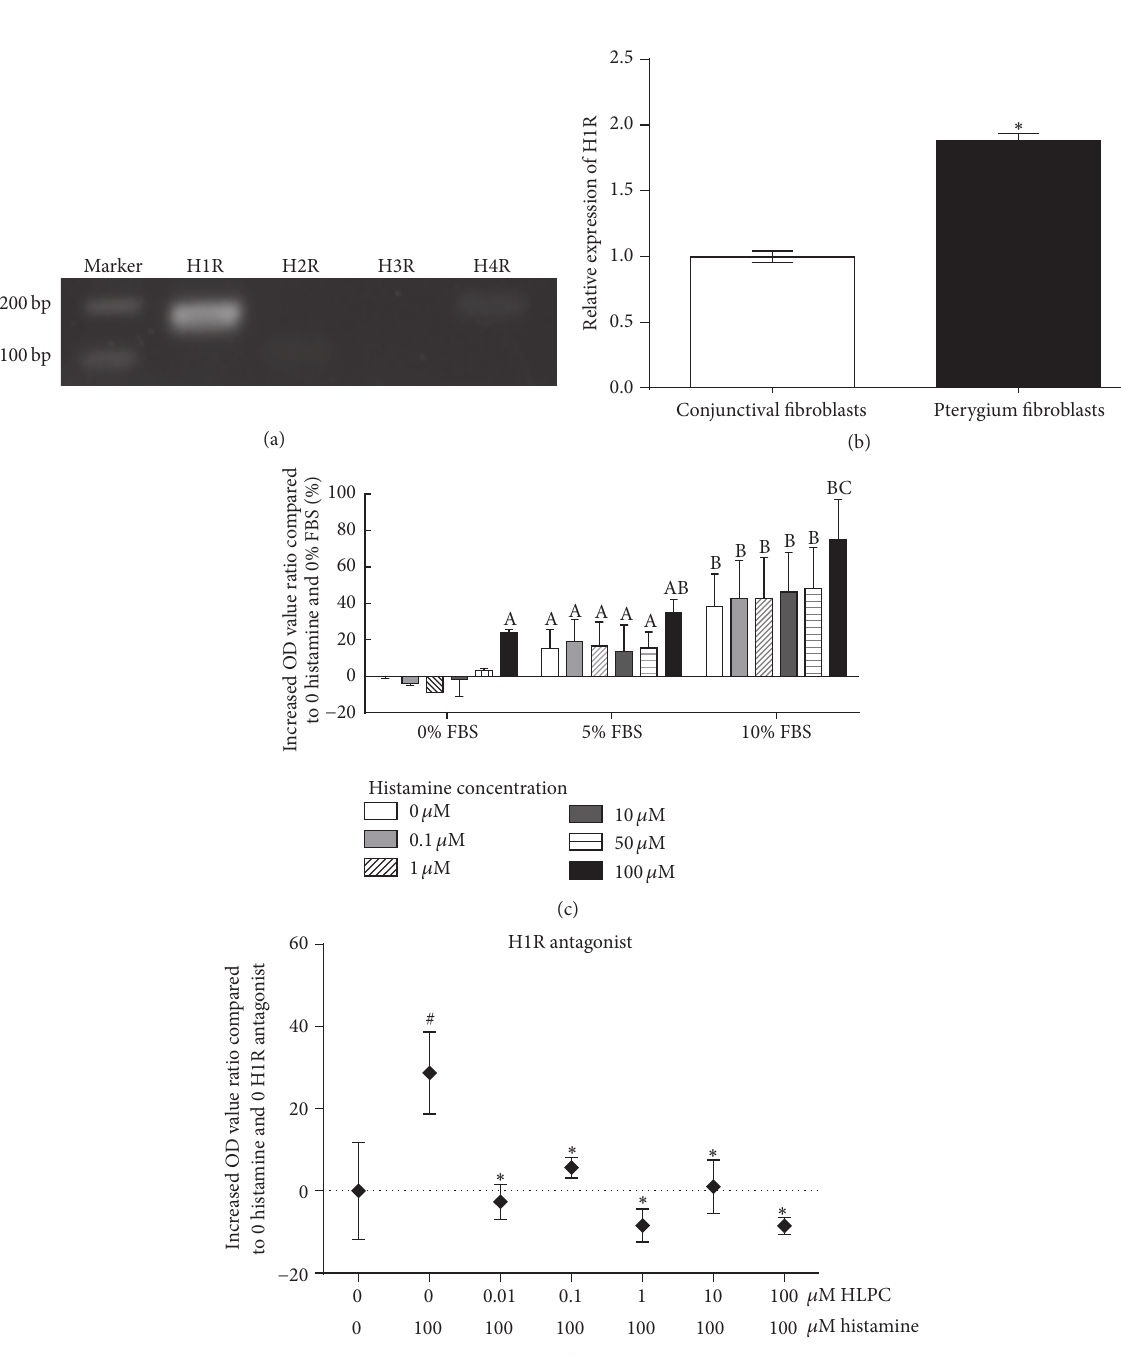
Figure 5: Histamine also showed proliferative effect on HCFs but at a higher effective concentration than on HPFs. (a) DNA agarose gel electrophoresis showed the expression of H1R, H2R, and H4R on HCFs, and the expression of H2R and H4R was quite few. (b) RT-qPCR showed that the expression of H1R in HCFs was only half of those in HPFs. (c) MTT assay showed that histamine had proliferative effect on HCFs in 0%, 5%, and 10% FBS situation at concentration of 100 𝜇 mol/L. A 𝑃 < 0.05 compared to 0 histamine and 0% FBS, B 𝑃 < 0.05 compared to 0 histamine and 5% FBS, C 𝑃 < 0.05 compared to 0 histamine and 10% FBS. (d) MTT assay showed that H1R antagonist could efficiently inhibit the proliferative effect of histamine. ∗ 𝑃 < 0.05 compared to incubation with 100 𝜇 mol/L of histamine alone. # 𝑃 < 0.05 compared to incubation without histamine and